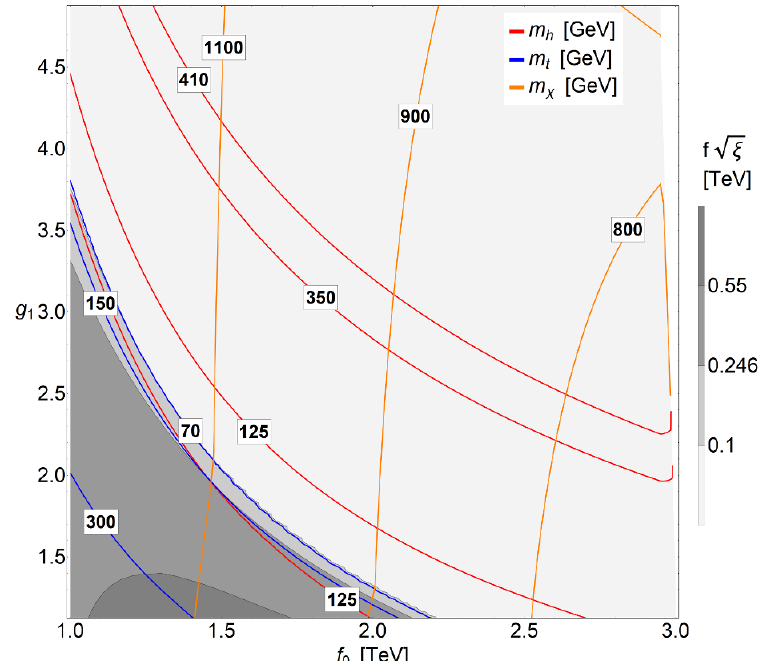
p (cid:24) = v and the masses of the Higgs boson ( m H ), the top quark ( m t )